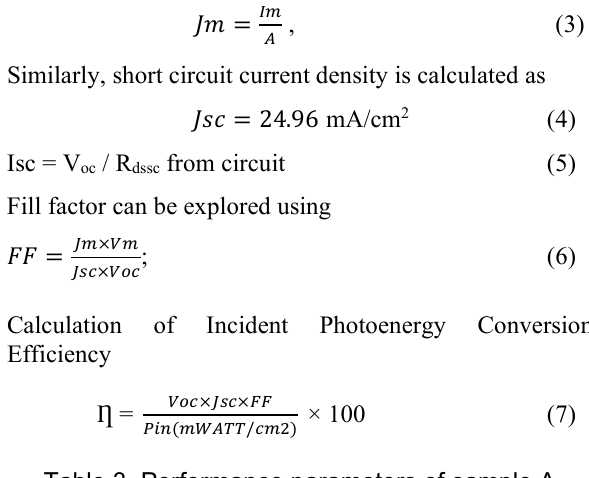
Table 3. Performance parameters of sample